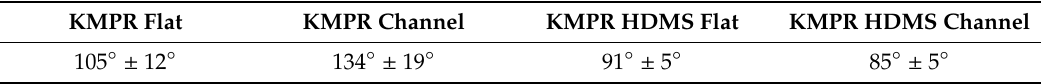
Table 1. Results of contact angle measurements of KMPR photoresists on various surfaces.